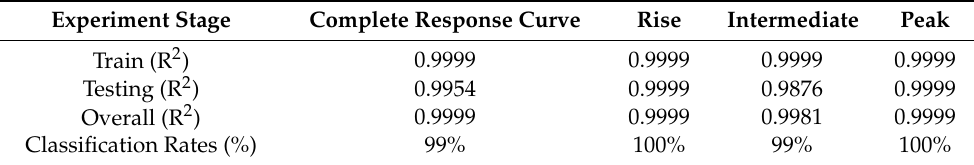
Table 10. Correlation values with ANN application during training